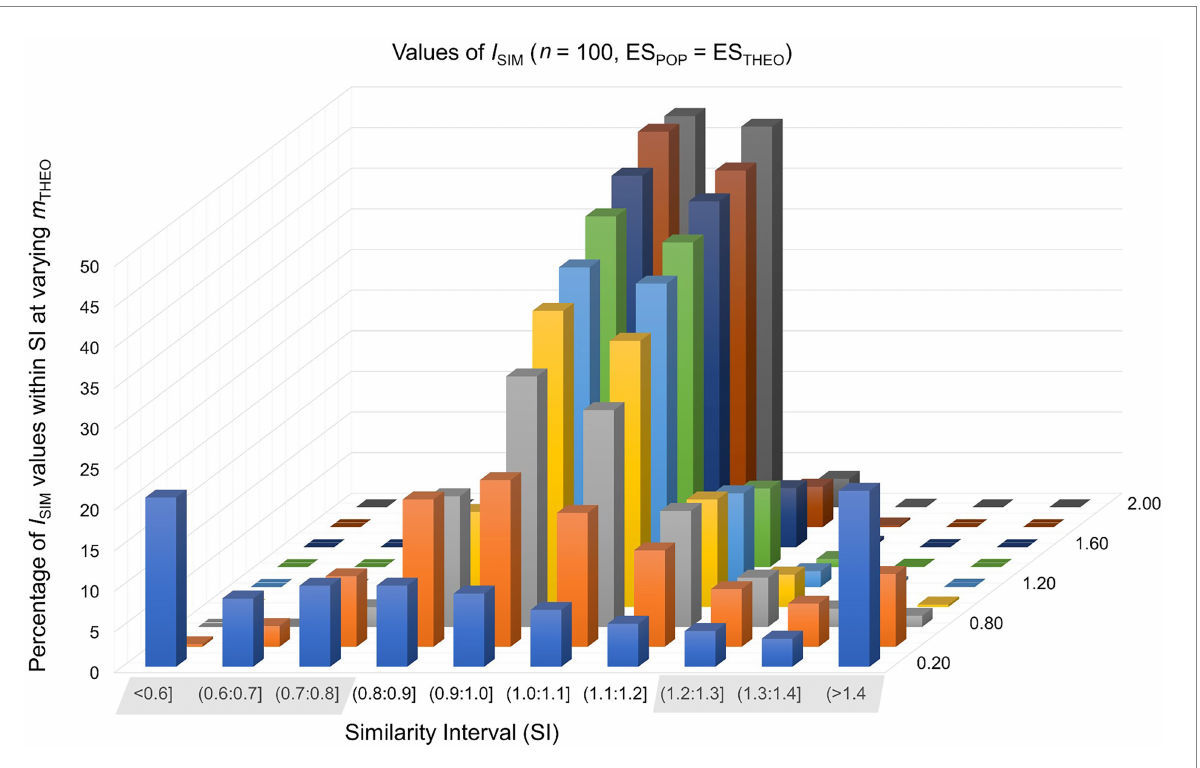
FIGURE 1 Values of I SIM were calculated in 10,000 simulated study-settings with n 0 = n 1 = 100 under the assumption that the theoretically predicted effect matches the population effect. Each row of this graph represents different values of m THEO